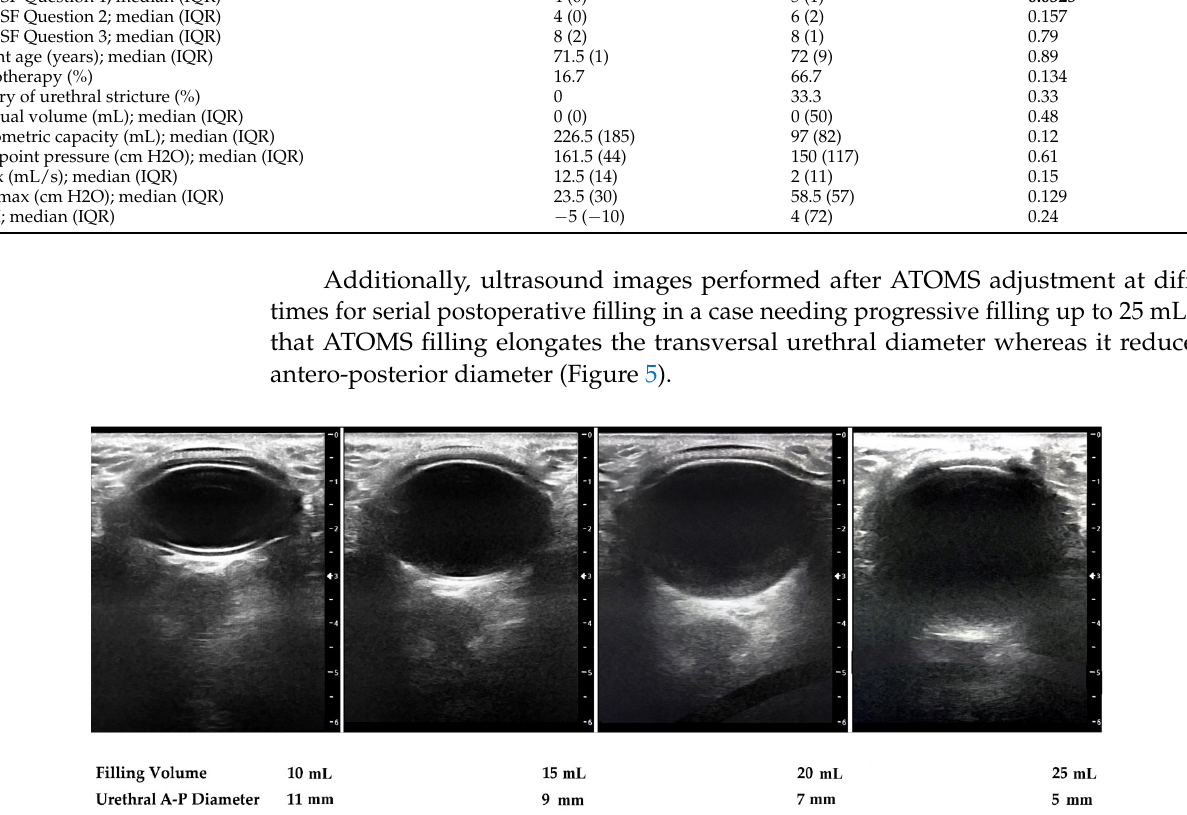
Figure 5. Sonographic perineal evaluation with lineal probe shows urethral diameter (antero-posterior) diminishes with the increase in ATOMS filling volume.